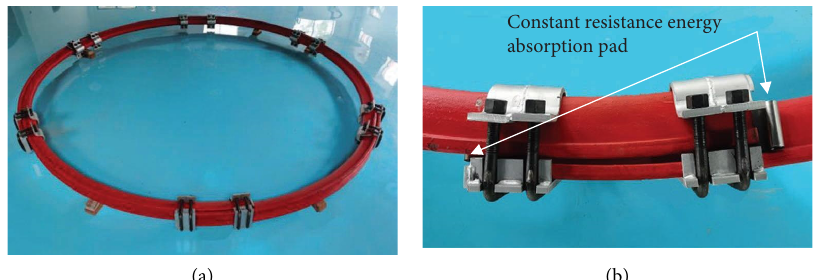
Figure 15: Te physical picture of the stable structure is constant resistance energy absorption in an“ O ” type shed. (a) Te overall picture. (b) An enlarged view of the lap and the curved constant resistance